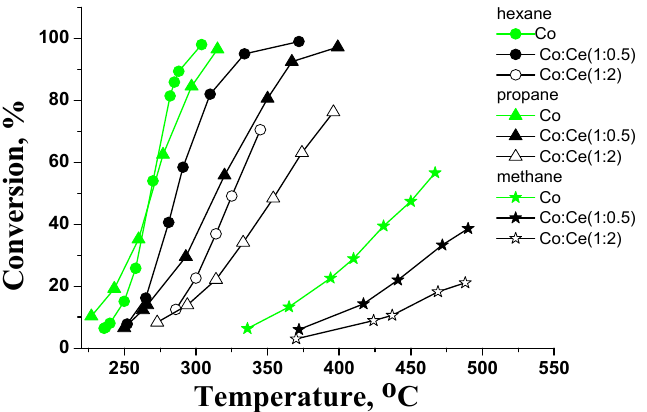
Figure 9. Temperature dependence of methane, propane, and n- hexane combustion.